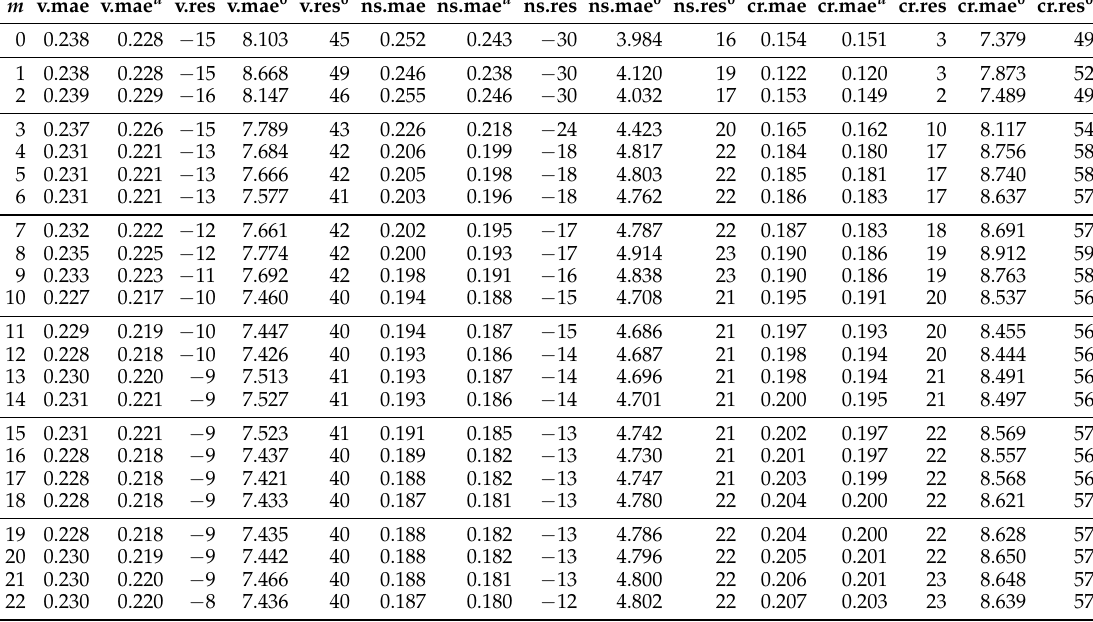
Table A26. Iteration-wise out-of-sample validation figures in adaptive variance model selection of BEL corresponding to M max 2,6,10,14,18,22 based on the 150–443 OLS proxy function given in ∈ { } Table A1 with exponents summing up to at max two. Simultaneously type I FGLS regression results.